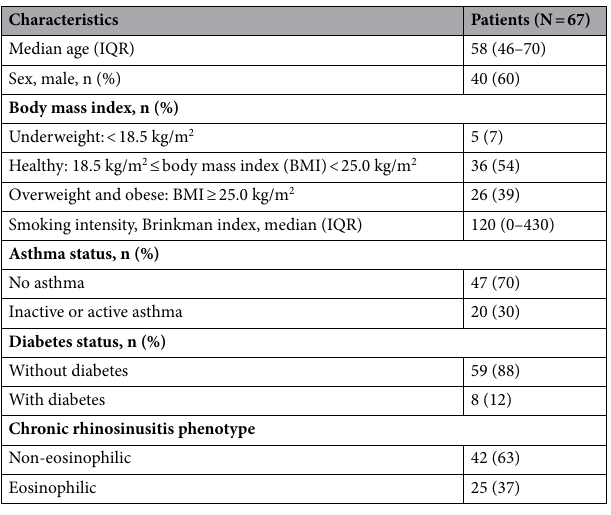
Table 1. Sociodemographic and medical characteristics of the patients. IQR interquartile